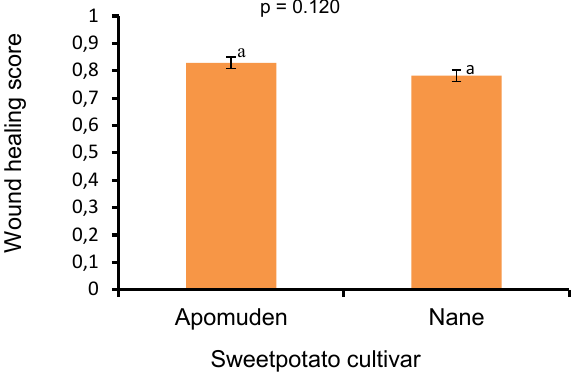
Figure 1: Average wound healing score of sweetpotato cultivars over 7-day curing period. Bar values (least square means ± SEM, n = 3). Least square means with the same letters are not signifi- cantly different (p >